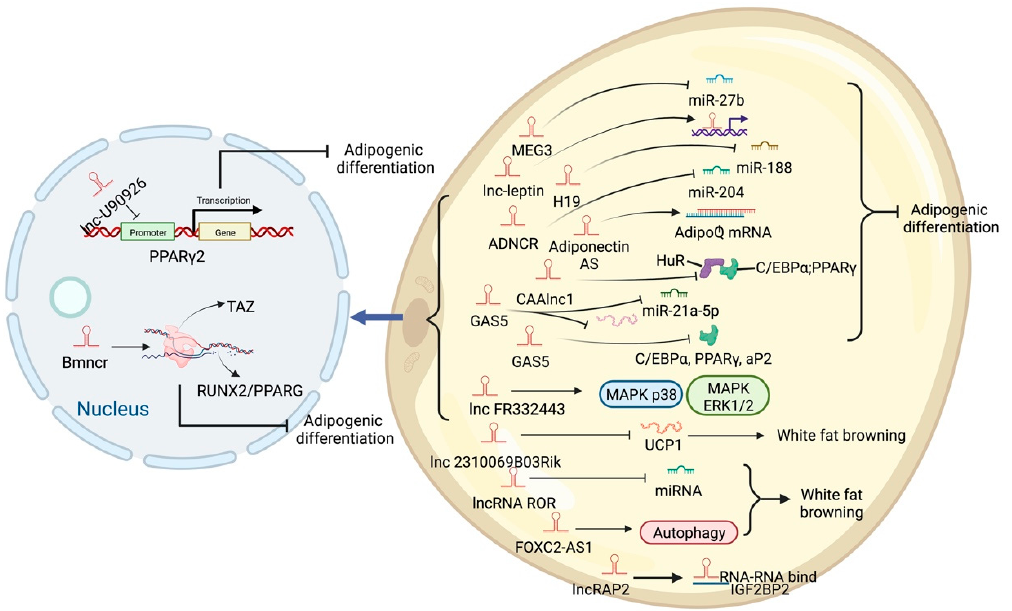
Figure 3. Schematic diagram of the biological function of lncRNA that promotes lipid deposition of white fat.